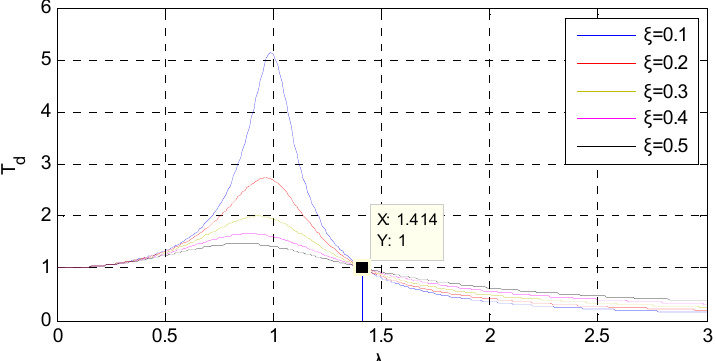
Figure 19. Vibration transmission characteristics of the passive vibration isolation system.